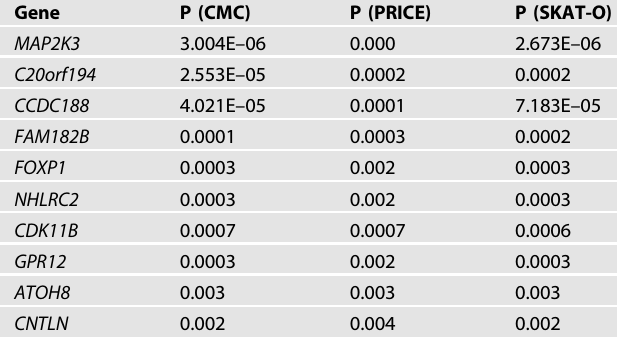
Table 3. Gene-based association results in the whole exome sequencing